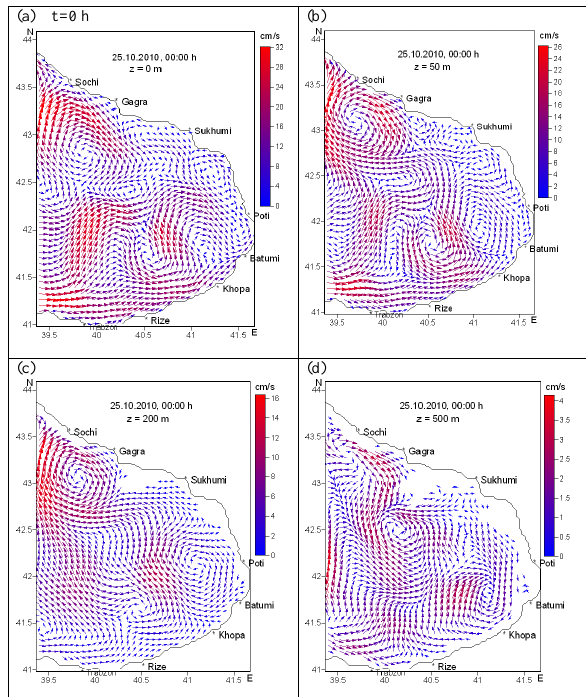
Fig. 11 . Current field at 25.10.2010, 00:00 h on depths of 0 m (a), 50 m (b), 200 m (c), and 500 m (d). Fig. 11. Current field at 25 October 2010, 00:00h on depths of 0m (a) , 50m (b) , 200m (c) , and 500m (d) .